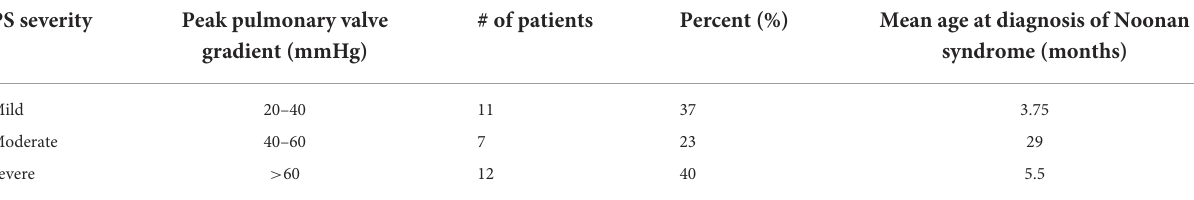
TABLE 3 Pulmonary stenosis